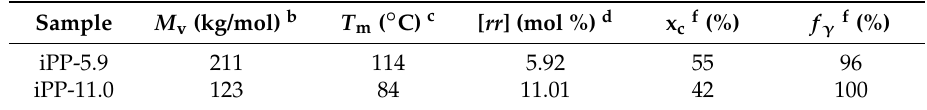
Table 1. Molecular mass ( M v ), melting temperature ( T m ) and content of rr triads of iPP